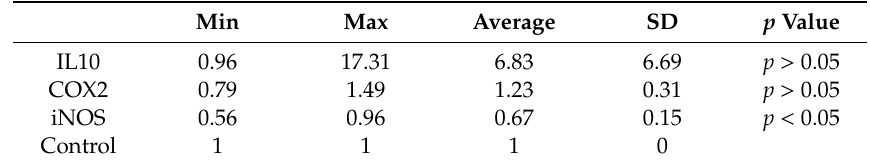
Table 2. Immunomodulation properties of L. paracasei FS109 strain in human THP-1 cells. after co-culture for 4